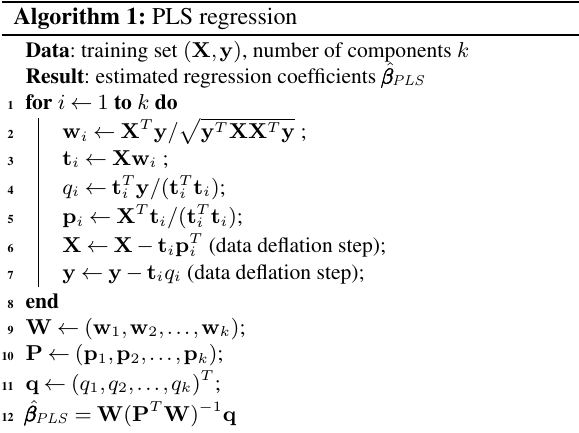
Algorithm 1. PLS